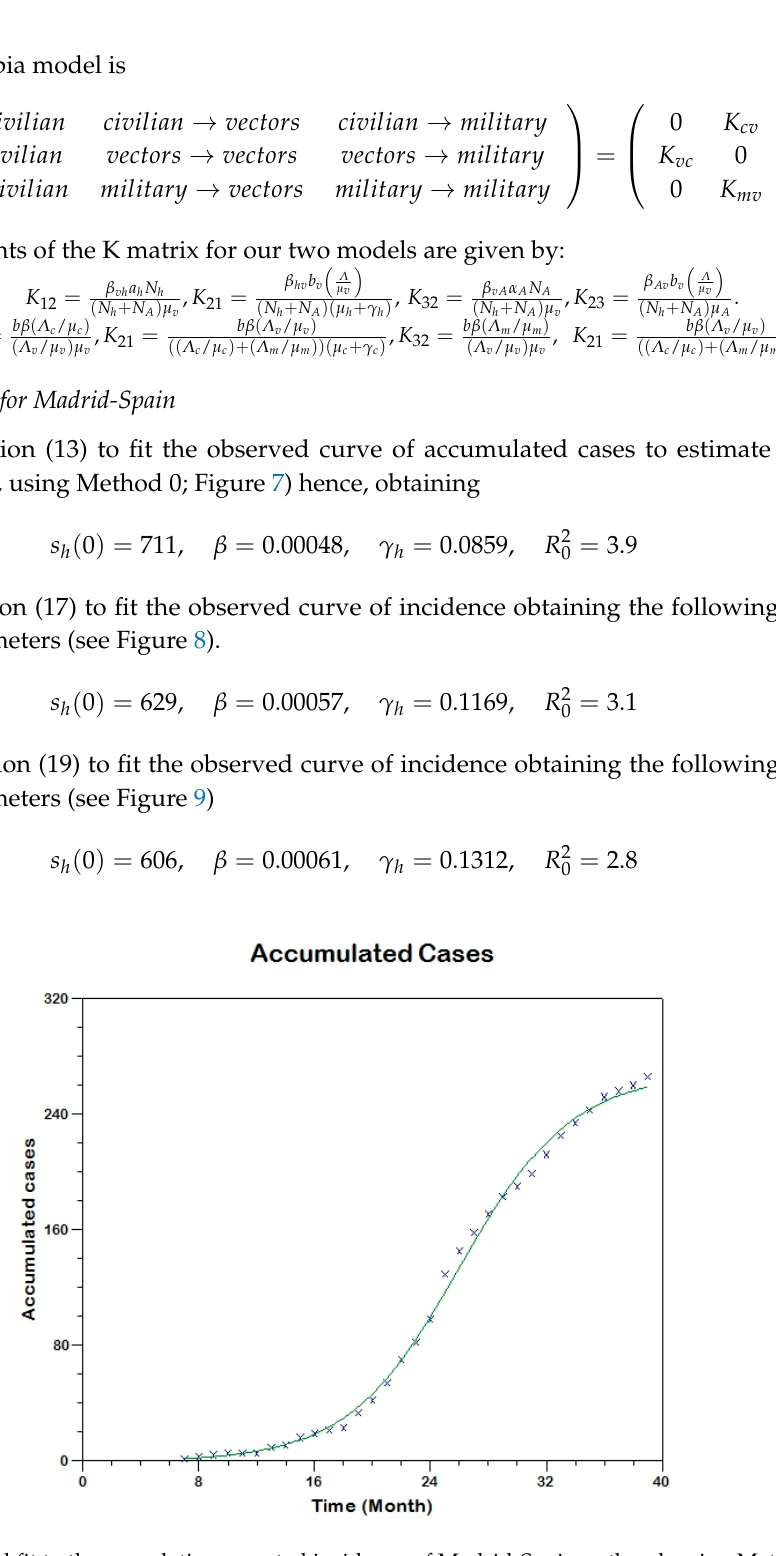
Figure 8. Model fit to the reported incidence of Madrid-Spain outbreak using Method 1.